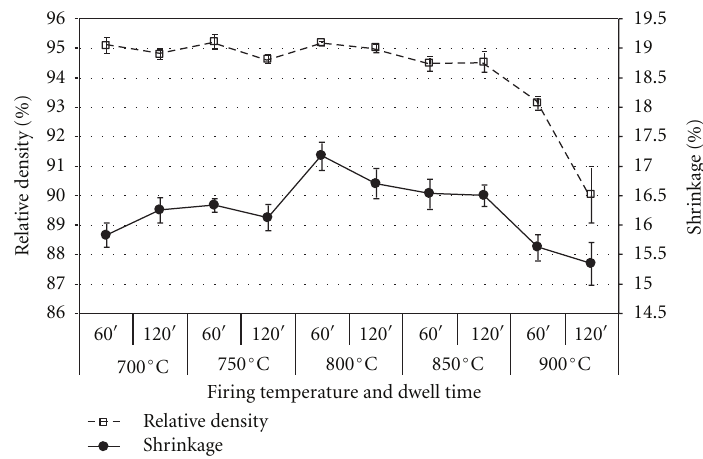
Figure 4: Relative density and shrinkage of LZSA as a function of di ff erent firing profiles.